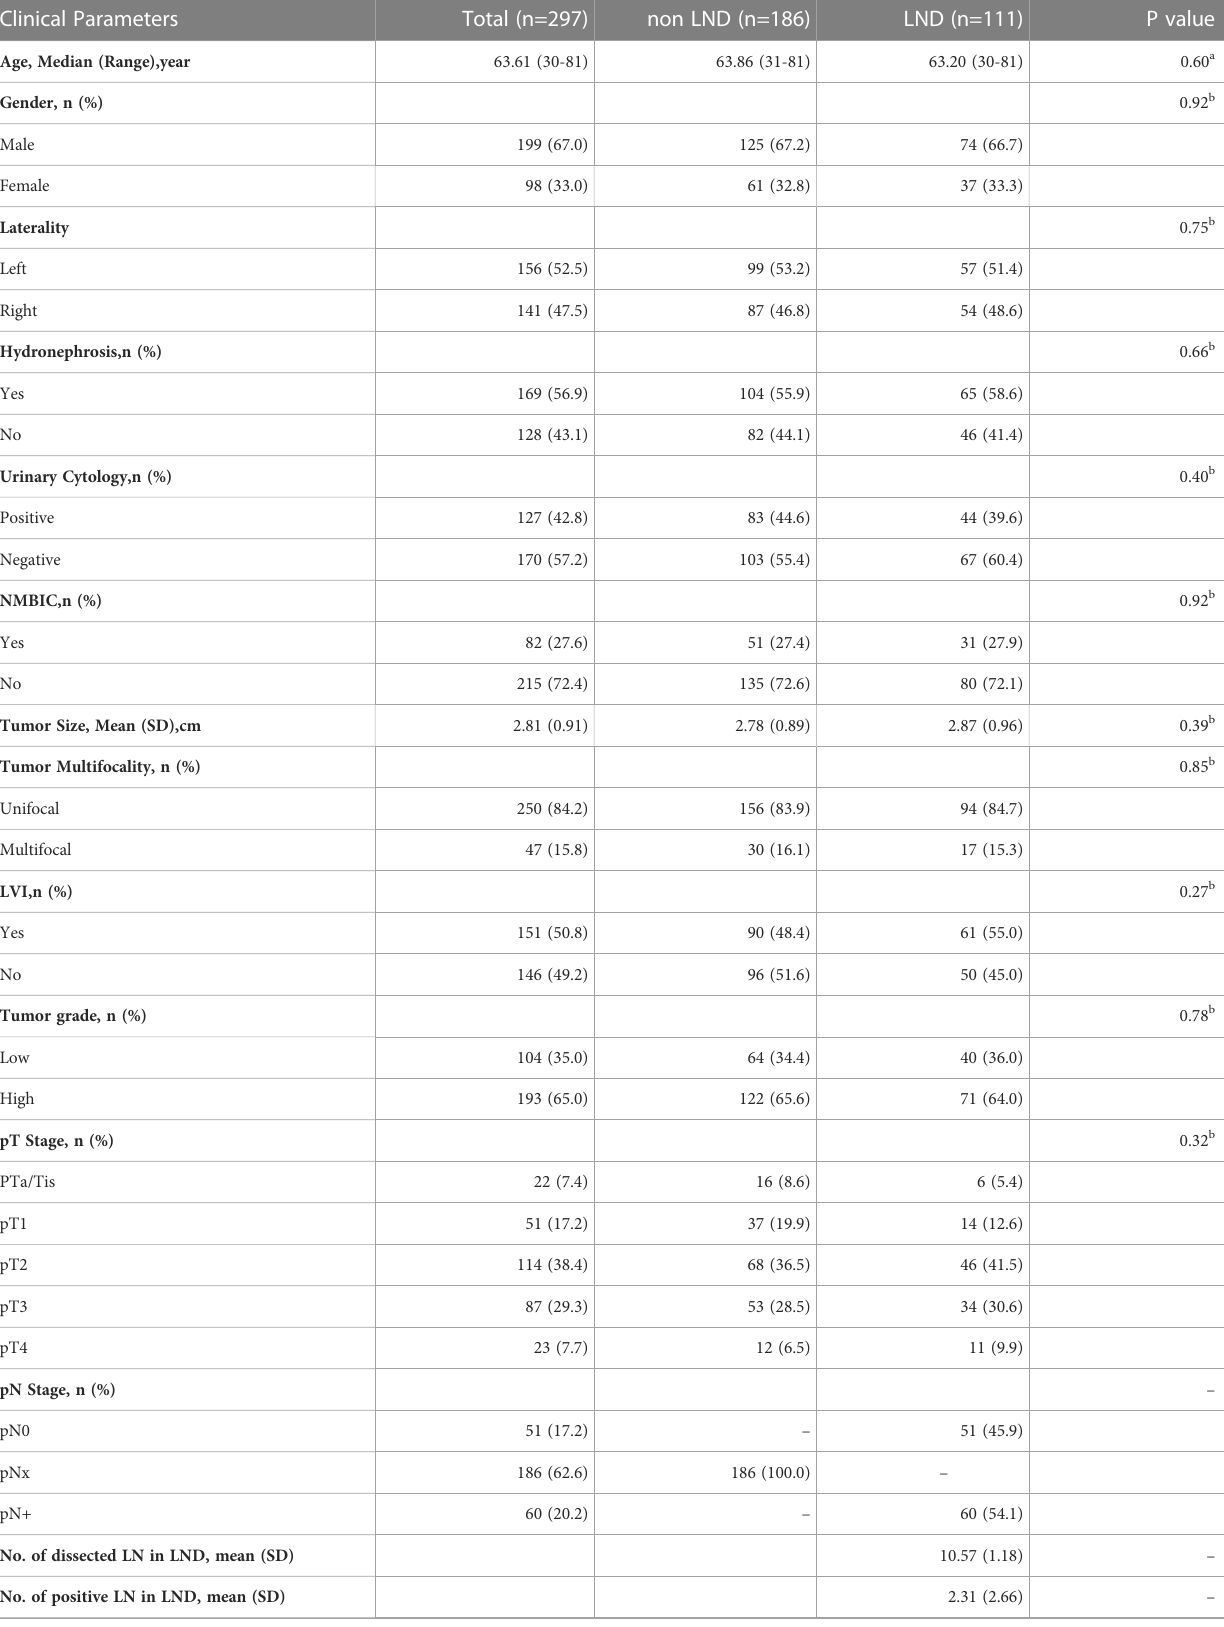
TABLE 1 Baseline characteristics of the study cohort and comparative analysis results according to surgical method. Clinical